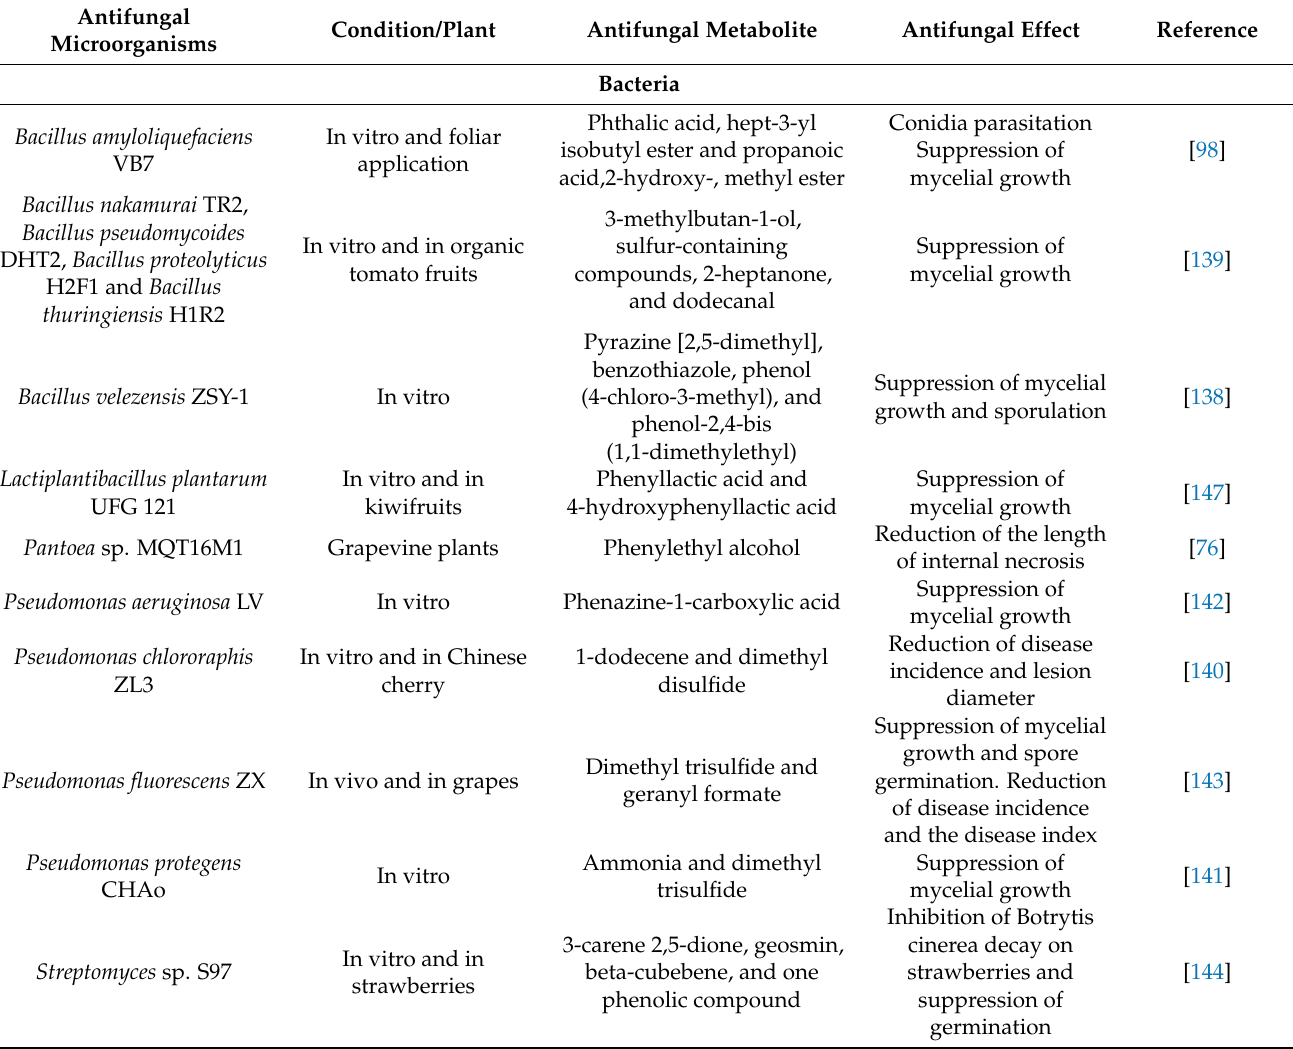
Table 2. Overview of literature reporting the inhibition of Botrytis cinerea by volatile antifungal metabolites